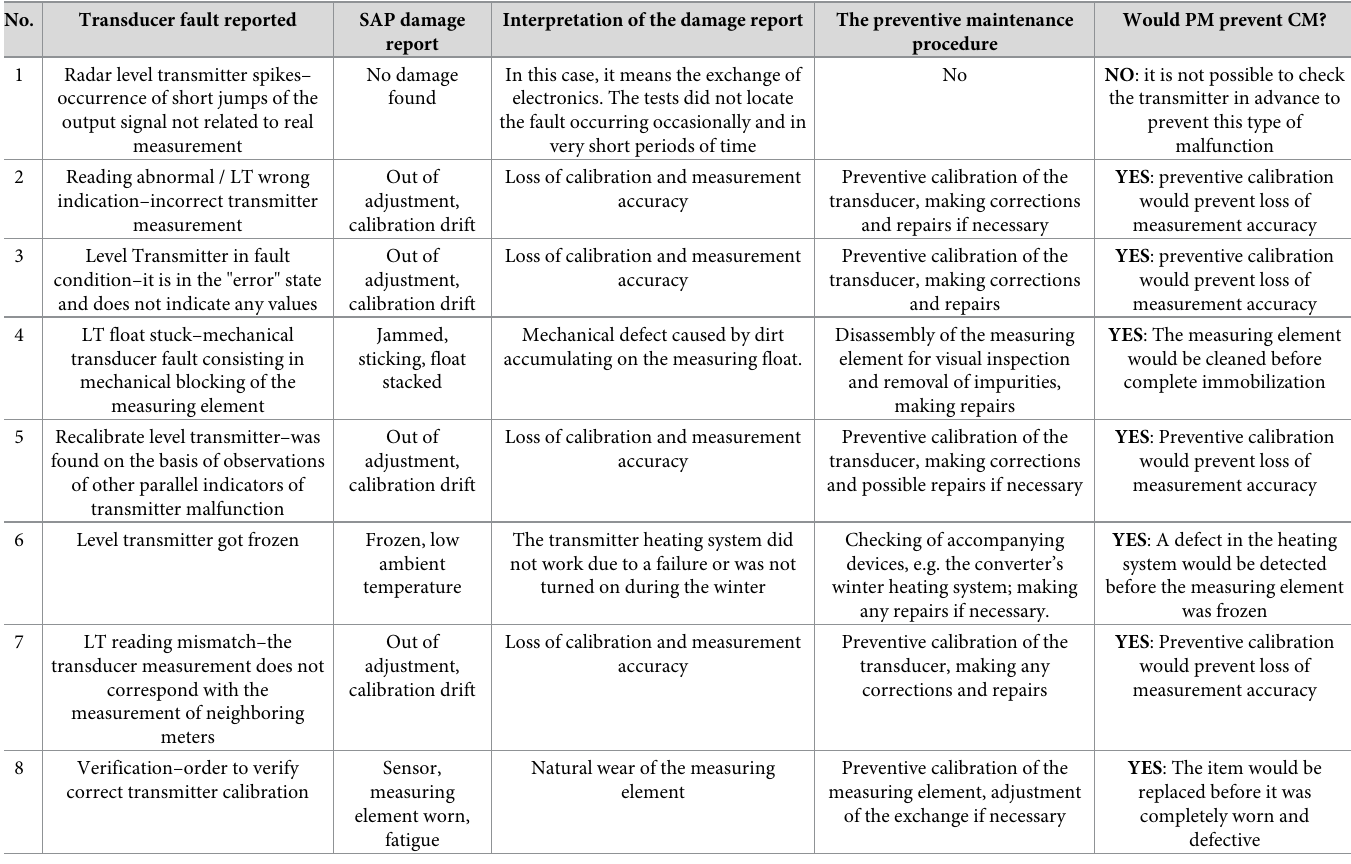
Table 4. Potential PM impact on CM prevention in the population studied.